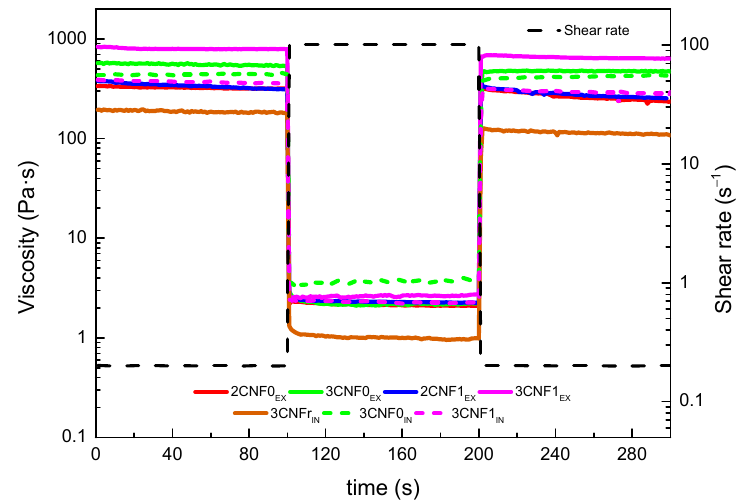
Figure 5. Structure recovery tests of WBPUU/CNF inks.